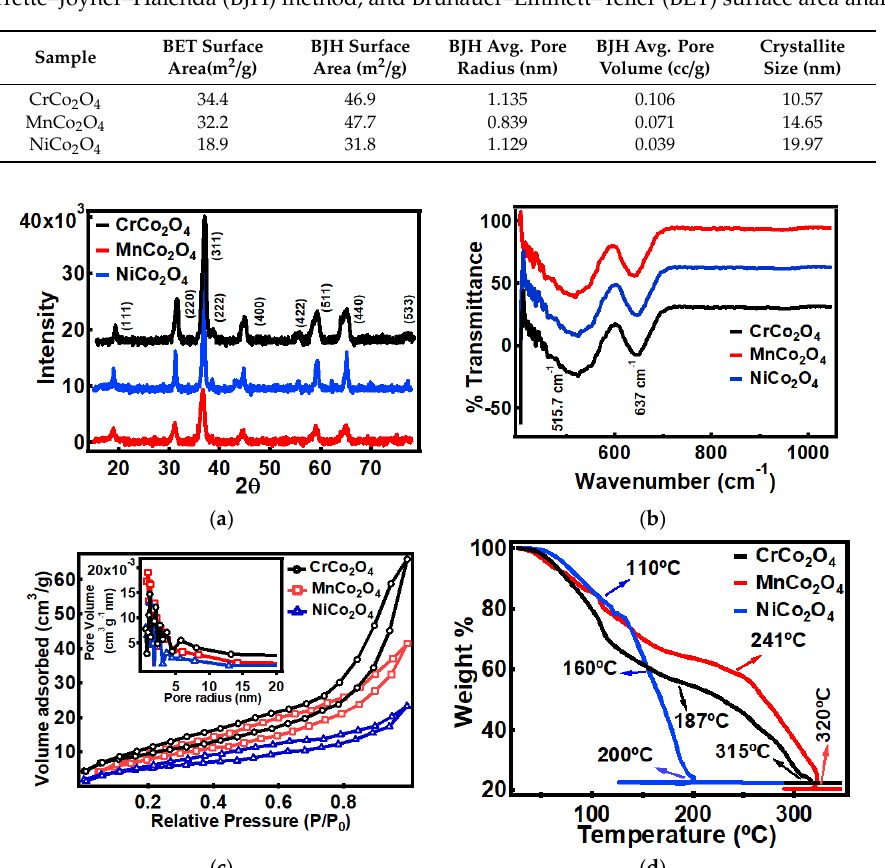
Figure 1. ( a ) x-ray diffraction pattern, ( b ) FTIR, ( c ) adsorption-desorption curve and inset pore volume distribution, and ( d ) thermogravimetric curve of tubular MCo 2 O 4 (M = Cr, Mn, Ni) structures.